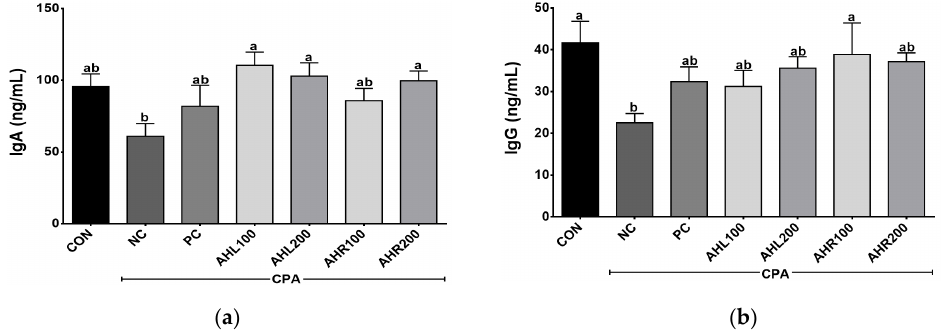
Figure 6. Effects of A. hookeri leaves (AHL) and A. hookeri roots (AHR) extracts on serum ( a ) IgA and ( b ) IgG levels of C57BL/6 mice immunosuppressed by CPA. CON, normal control group; NC, negative control group; PC, positive control group; AHL100, AHL extract 100 mg/kg BW; AHL200, AHL extract mg/kg BW; AHR100, AHR extract 100 mg/kg BW; AHR200, AHR extract 200 mg/kg BW. Data was presented as the mean ± SEM (n = 12). a,b Different letters are significantly different at p < 0.05.